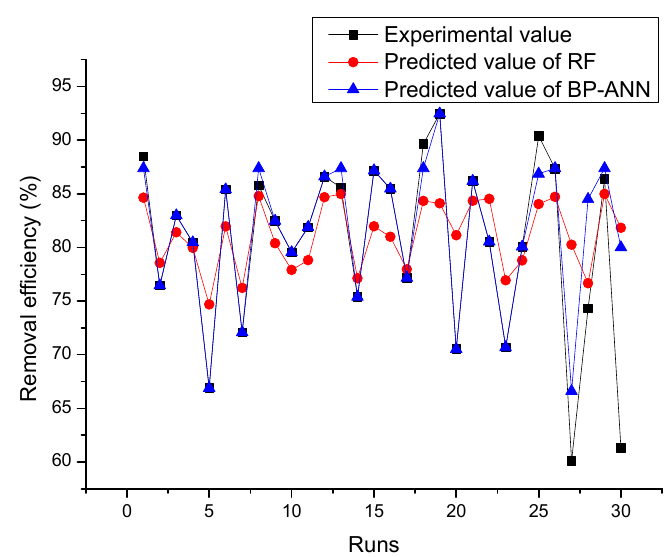
Figure 21. Comparison between experimental and predicted values of random forest (RF) and BP-ANN.